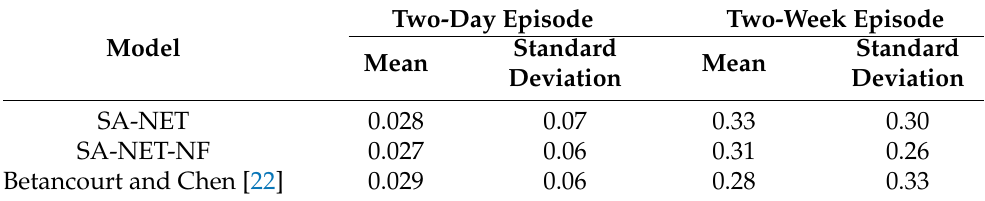
Table 5. Comparison of the performance of the algorithms in the two-day and two-week trading